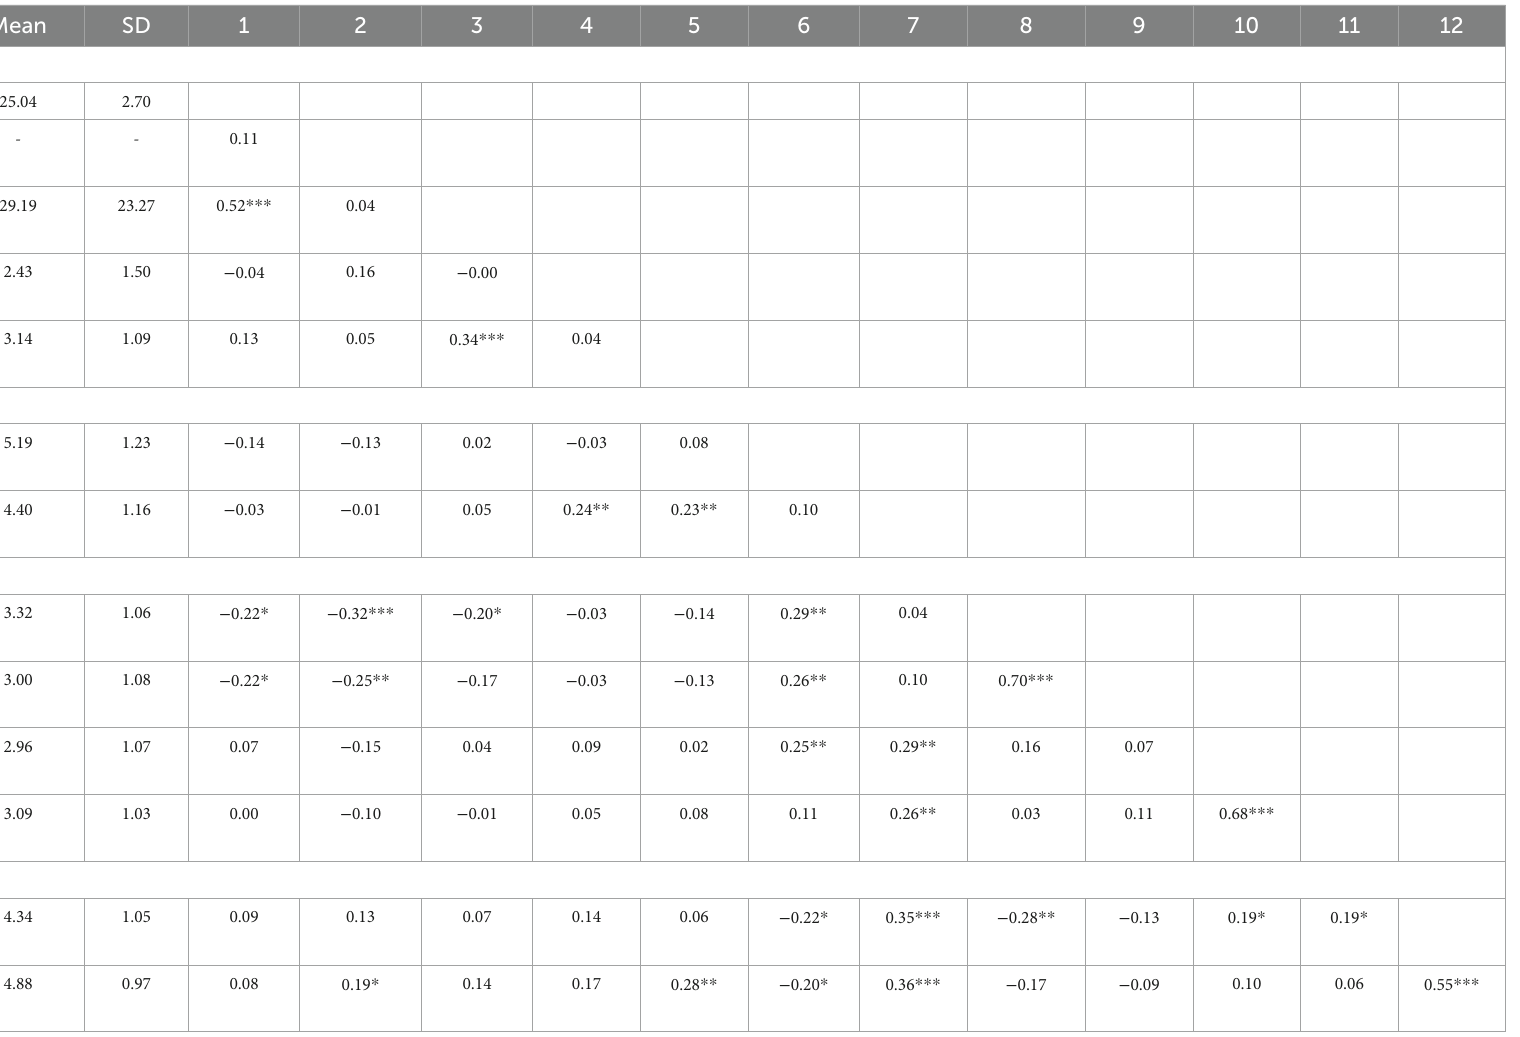
TABLE 1 Means, standard deviations, and Pearson’s correlations of all variables in Study